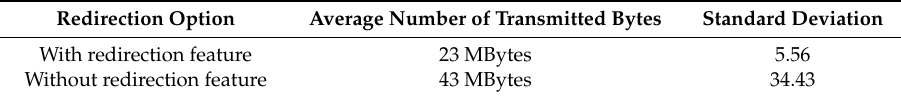
Table 4. Switch load with and without path redirection.